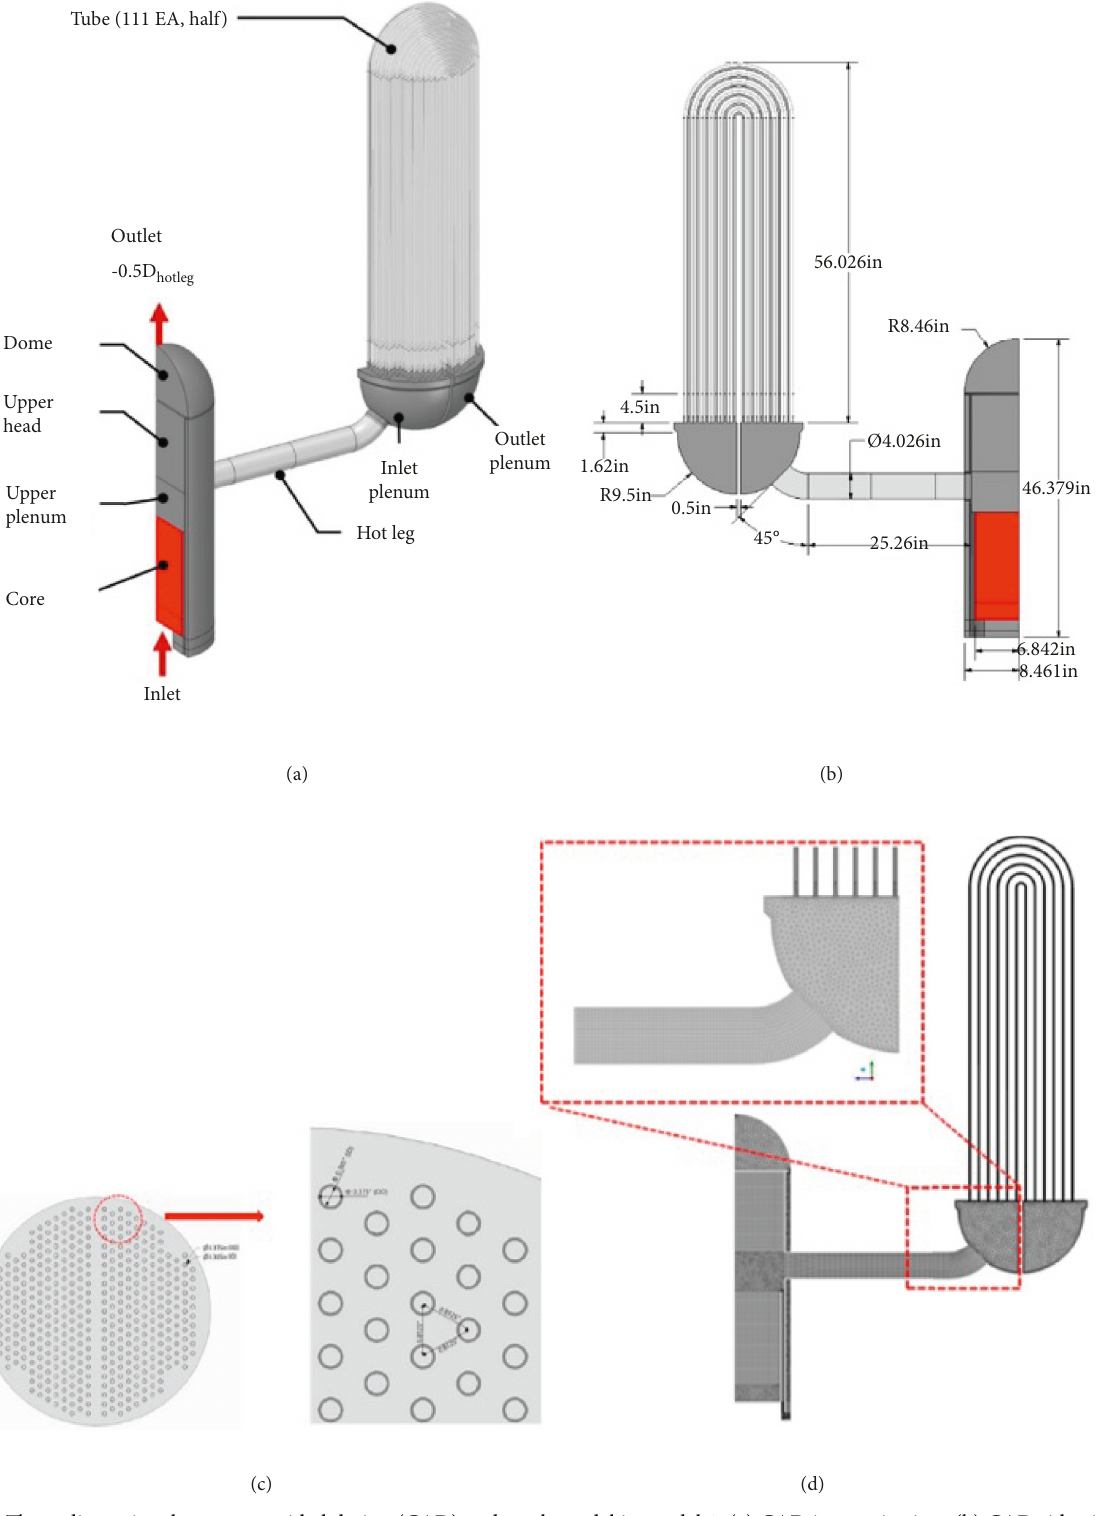
Figure 2: Three-dimensional computer-aided design (CAD) and mesh model in model 1. (a) CAD isometric view, (b) CAD side view, (c) CAD top view, and (d)